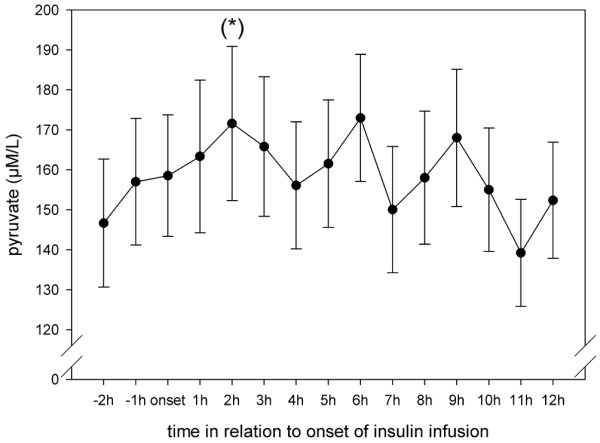
Course of cerebral extracellular pyruvate during insulin infusion. Data are expressed as mean ± standard error of hourly microdialysate concentrations from 24 patients treated with continuous intravenous insulin. Levels of significance are indicated for comparison with microdialysate concentrations at the start of insulin infusion (Wilcoxon signed-rank test). (*)P < 0.1.